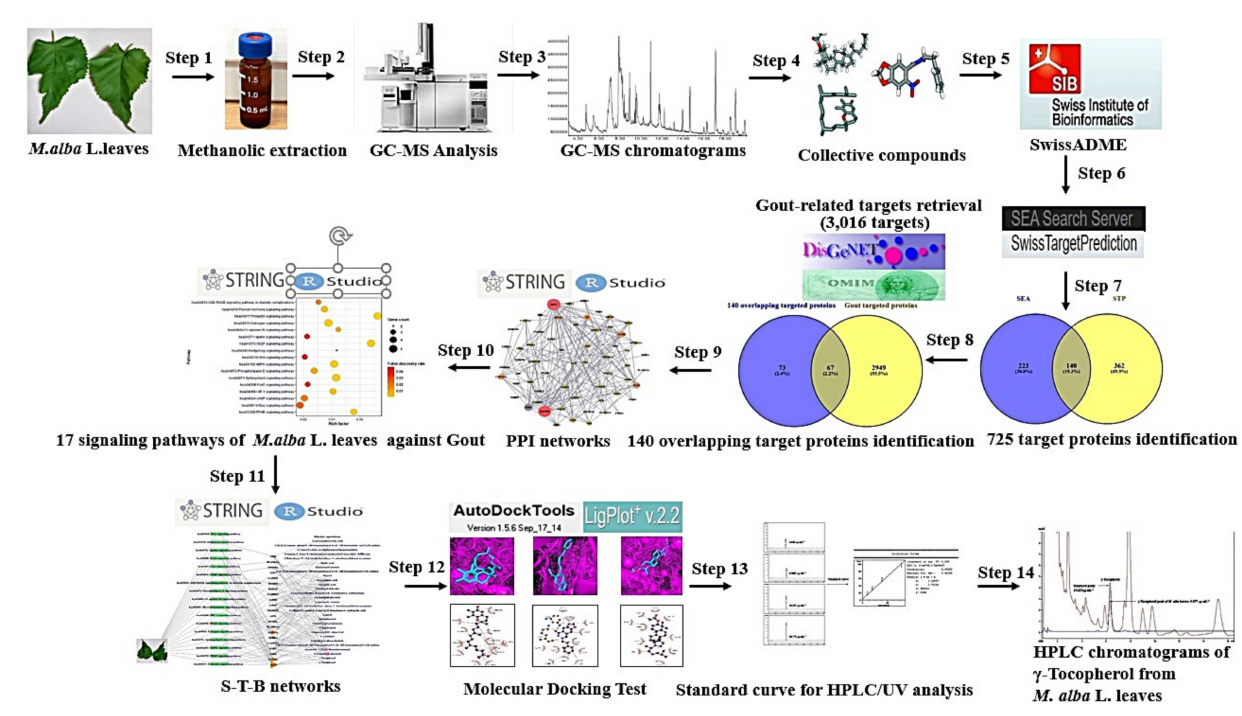
Figure 1. Workflow of network pharmacology analysis of M. alba L. leaves against Gout.